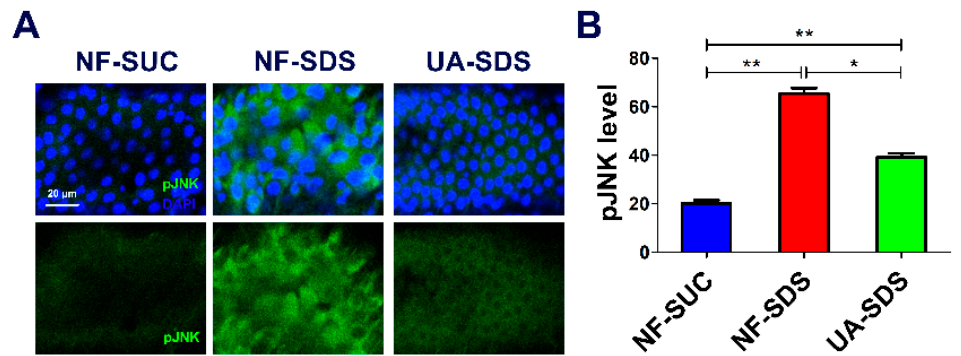
Figure 5. UA alleviated SDS-induced intestine damage by inhibiting c-Jun N-terminal kinase (JNK) signaling. ( A ) Immunohistochemistry indicated that the induced level of phosphorylated JNK (pJNK) as well as the aberrant nucleus morphology caused by SDS were attenuated by UA. ( B ) Quantification of pJNK levels in the intestines (n ≥ 6). * p < 0.05, ** p <